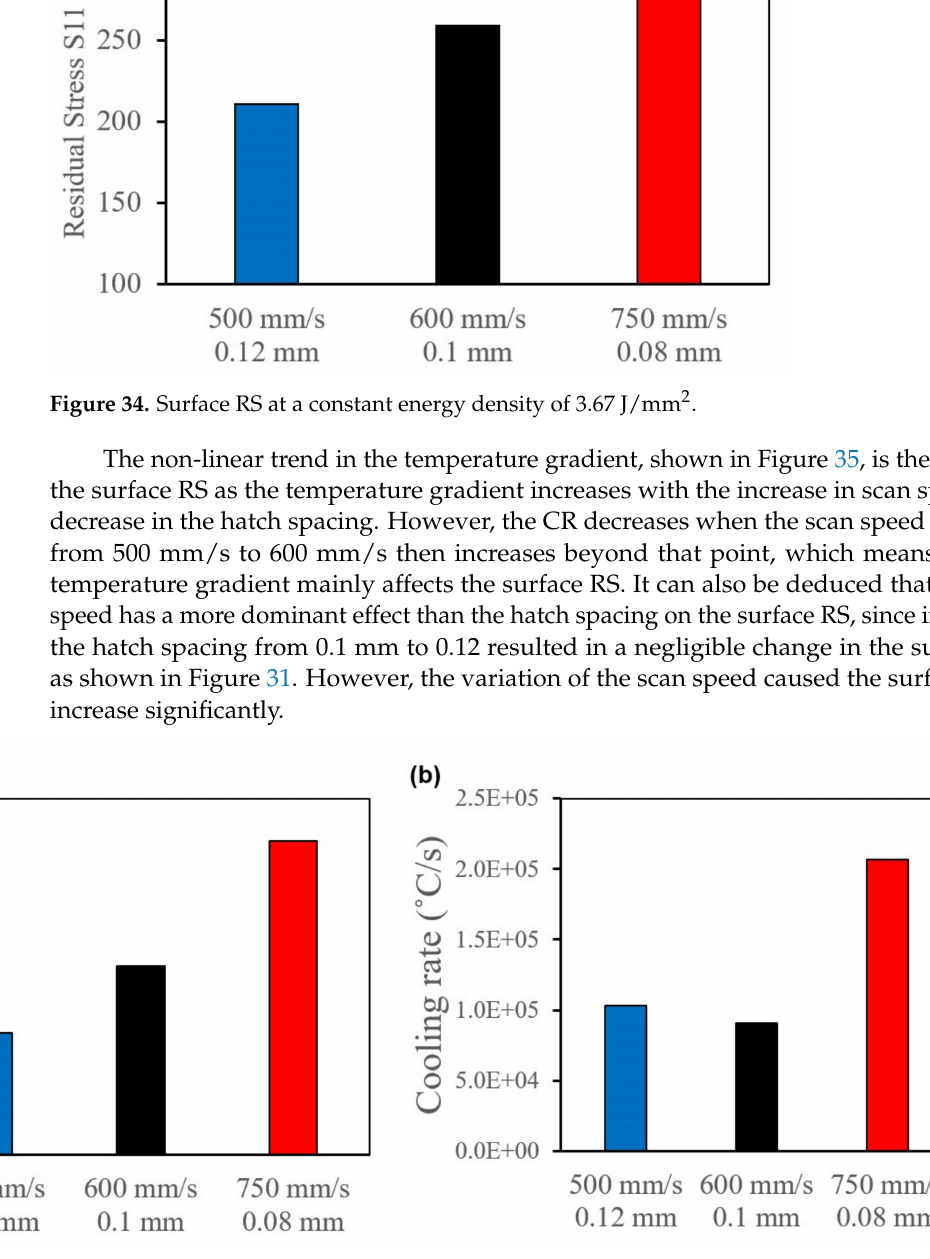
energy density, the laser power and scan speed are varied, while the hatch spacing is kept constant at 0.12 mm. Three power levels, 170 W, 220 W, and 270 W, and three scan